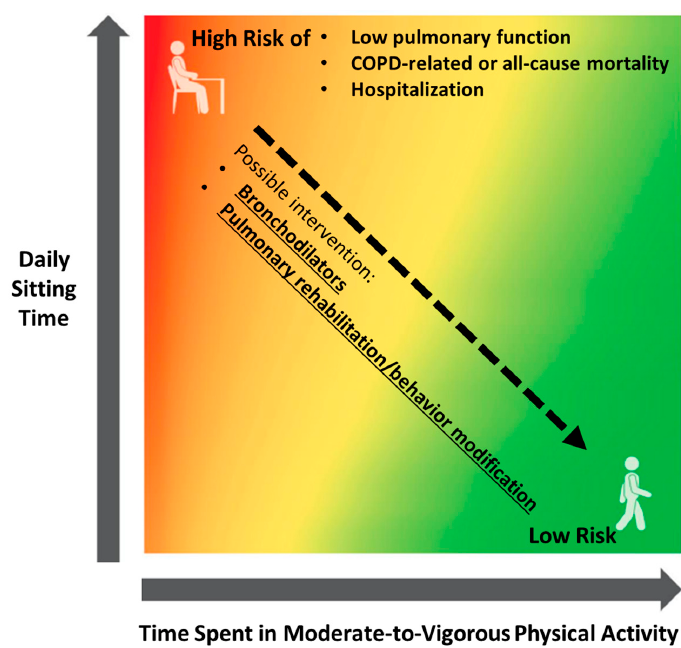
Figure 1. Risk of poor clinical outcomes of chronic obstructive pulmonary disease depending on physical activity and sedentary behavior, focusing on possible intervention.